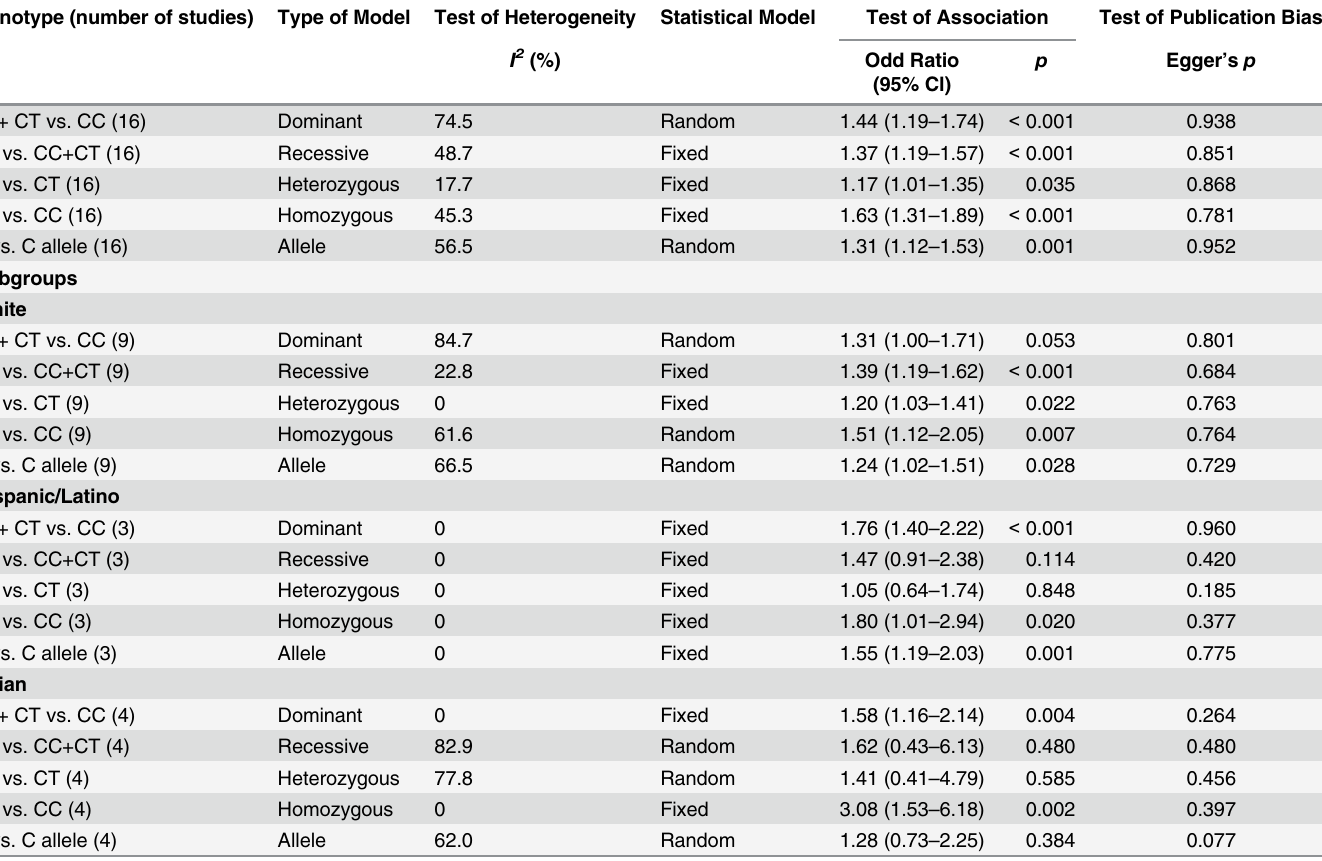
Table 3. Association between TCF7L2 rs7903146 polymorphisms and risk of gestational diabetes mellitus in overall sample and in sub-racial groups. Genotype (number of studies) Type of Model Test of Heterogeneity Statistical